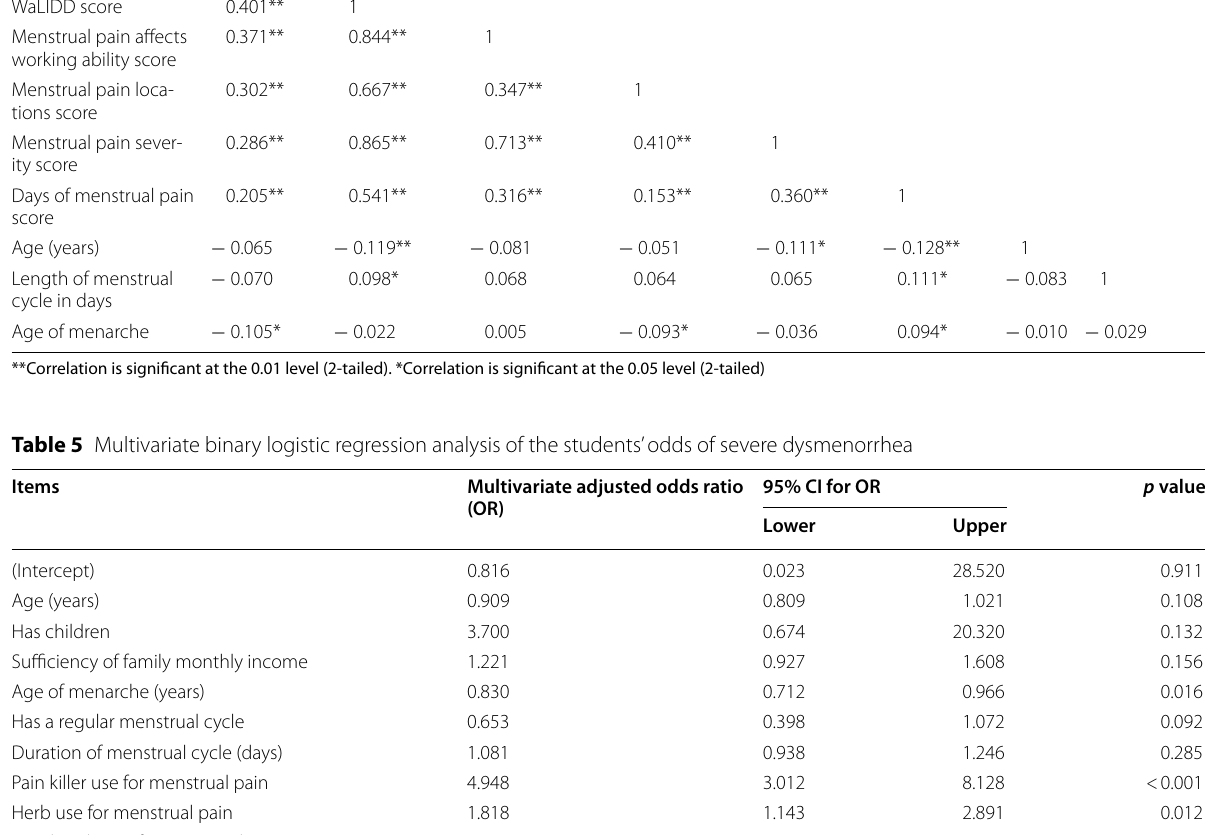
Table 4 Bivariate correlations between dysmenorrhea, depression, and other variables